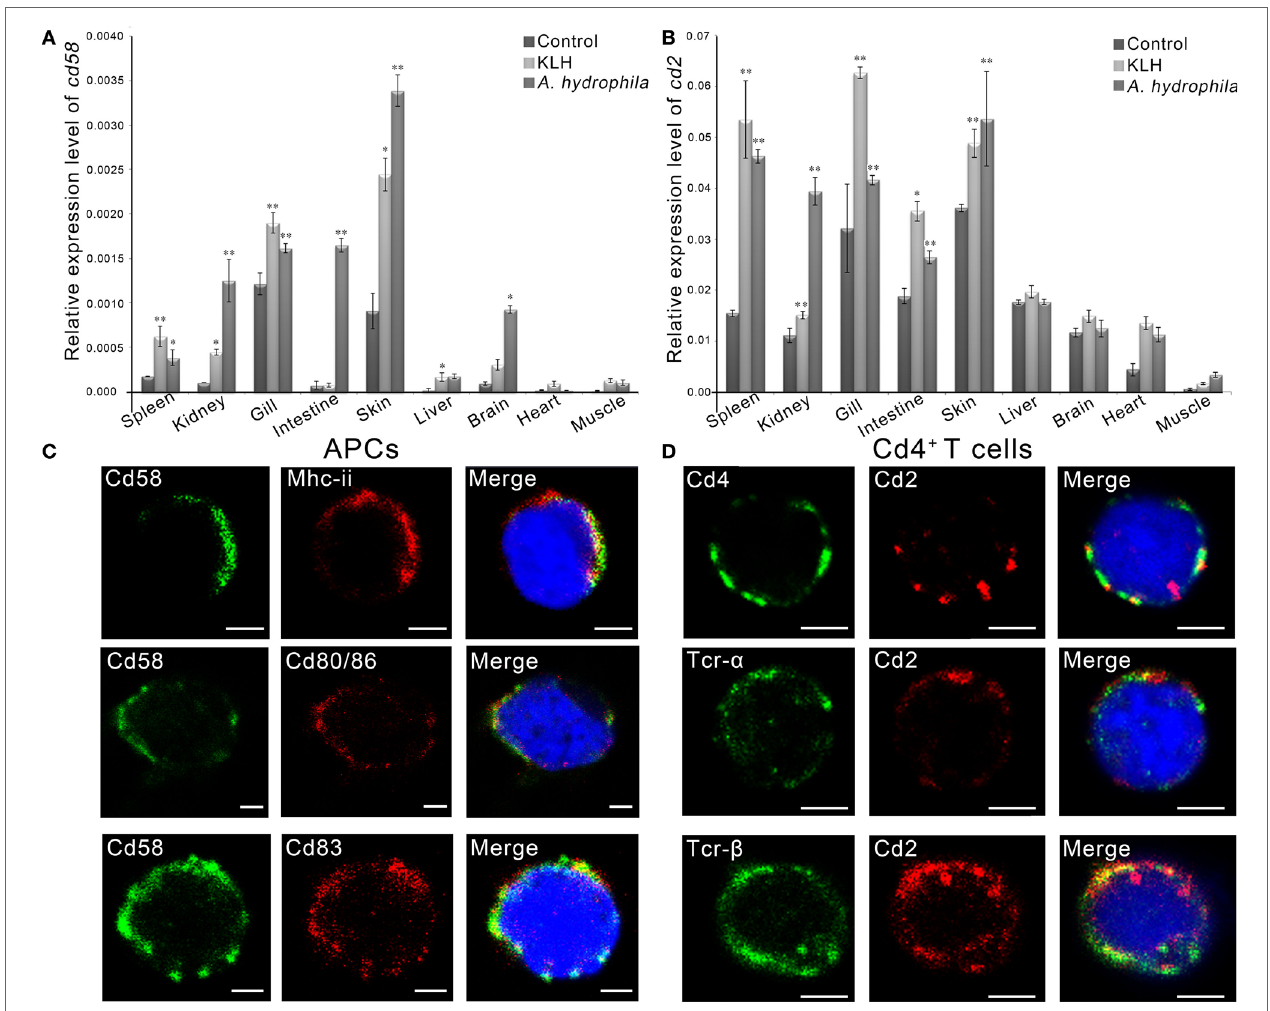
FigUre 5 | Tissue and cellular distribution analyses of Cd58 and Cd2. (a,B) Tissue distribution analyses of cd58 (a) and cd2 (B) in control fish or in antigen [keyhole limpet hemocyanin (KLH) or Aeromonas hydrophila ] challenged fish by real-time PCR. The relative gene expression profiles of cd58 and cd2 in various tissues were displayed as relative values to the expression levels of β -actin ( cd58 / β -actin and cd2 / β -actin), respectively. Each sample was obtained from 10 fish and run in triplicate parallel reactions. The experiments were repeated independently at least three times (* p < 0.05, ** p < 0.01). (c,D) Immunofluorescence staining of the leukocytes separated from the blood, spleen, and kidney tissues of the fish stimulated with KLH (in combination with lipopolysaccharide). Cells were stained with rabbit anti-Cd58 together with mouse anti-MHC class II (Mhc-ii), mouse anti-Cd80/86, or mouse anti-Cd83 (c) , or stained with mouse anti-Cd2 together with rabbit anti-Cd4, rabbit anti-Tcr- α , or rabbit anti-Tcr- β (D) . Nonrelated mouse and rabbit IgG isotypes were used as negative controls (data not shown). DAPI stain shows the location of the nuclei. The images were obtained using a two-photon laser scanning confocal microscope (Zeiss LSM-710; original magnification, 630 × ). An enlarged image of the target cell was generated by fourfold magnification. Scale bars, 2